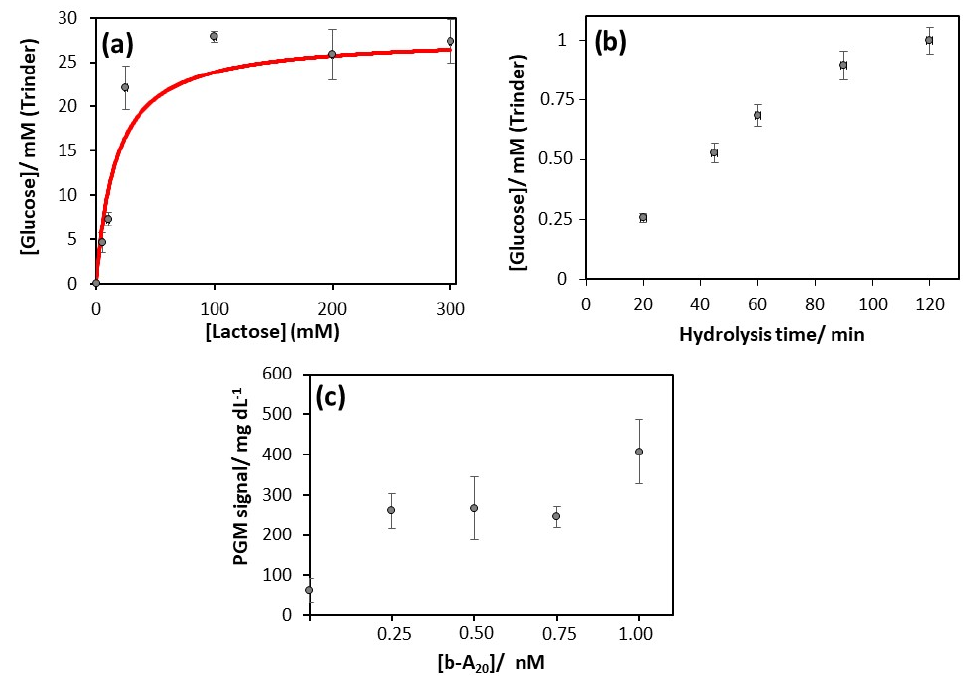
Figure 2. Studies of b-A 20 detection by using β -galactosidase as glucose-generating enzyme. ( a ) E ff ect of lactose concentration on the analytical signal obtained by Trinder method. Red line represents the fit based on Michaelis–Menten model. ( b ) E ff ect of enzymatic hydrolysis time on the analytical signal obtained by Trinder method. ( c ) Detection of the model target b-A 20 using the personal glucose meter under the optimized